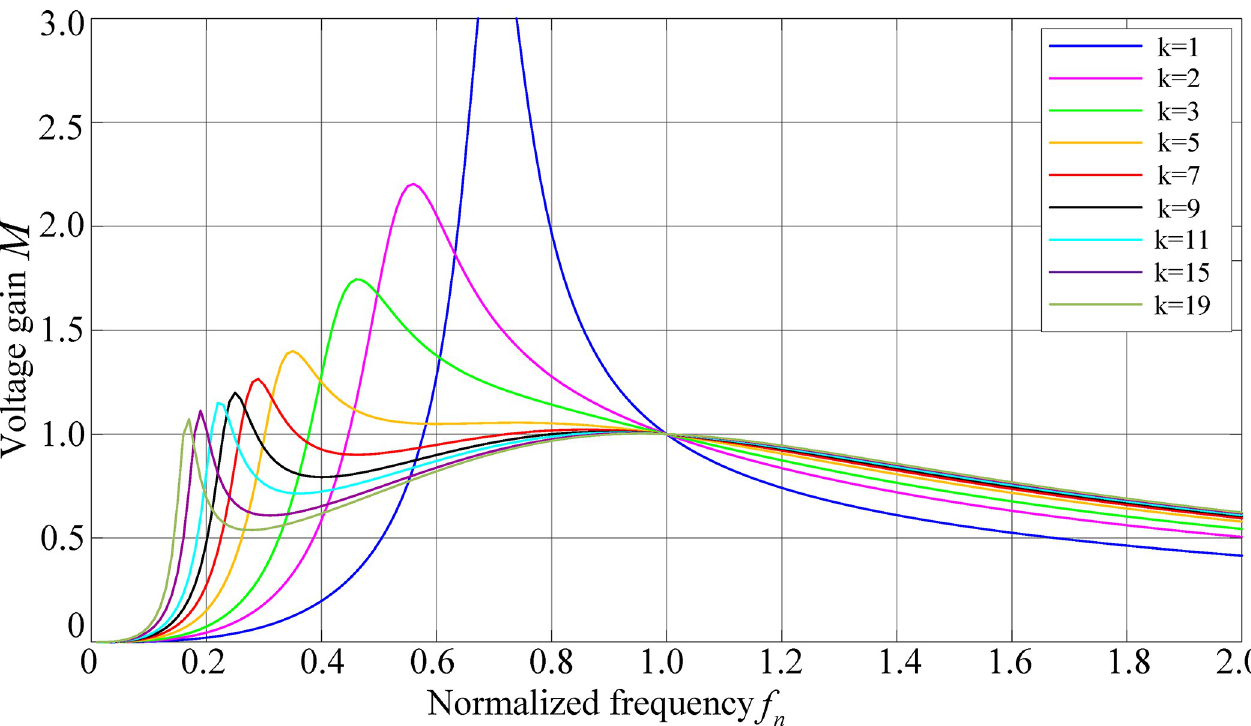
Fig 9. The influence of inductance coefficient on voltage gain characteristics.